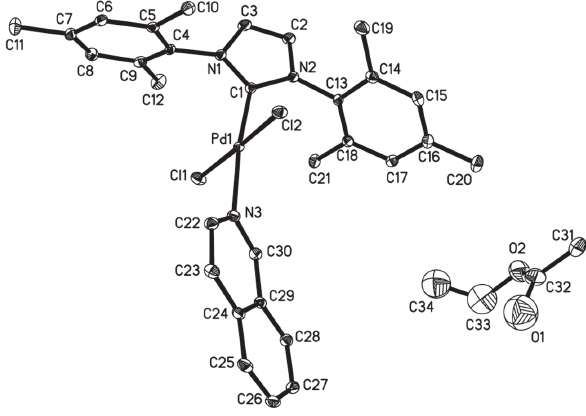
Table 1: Data collection and handling.